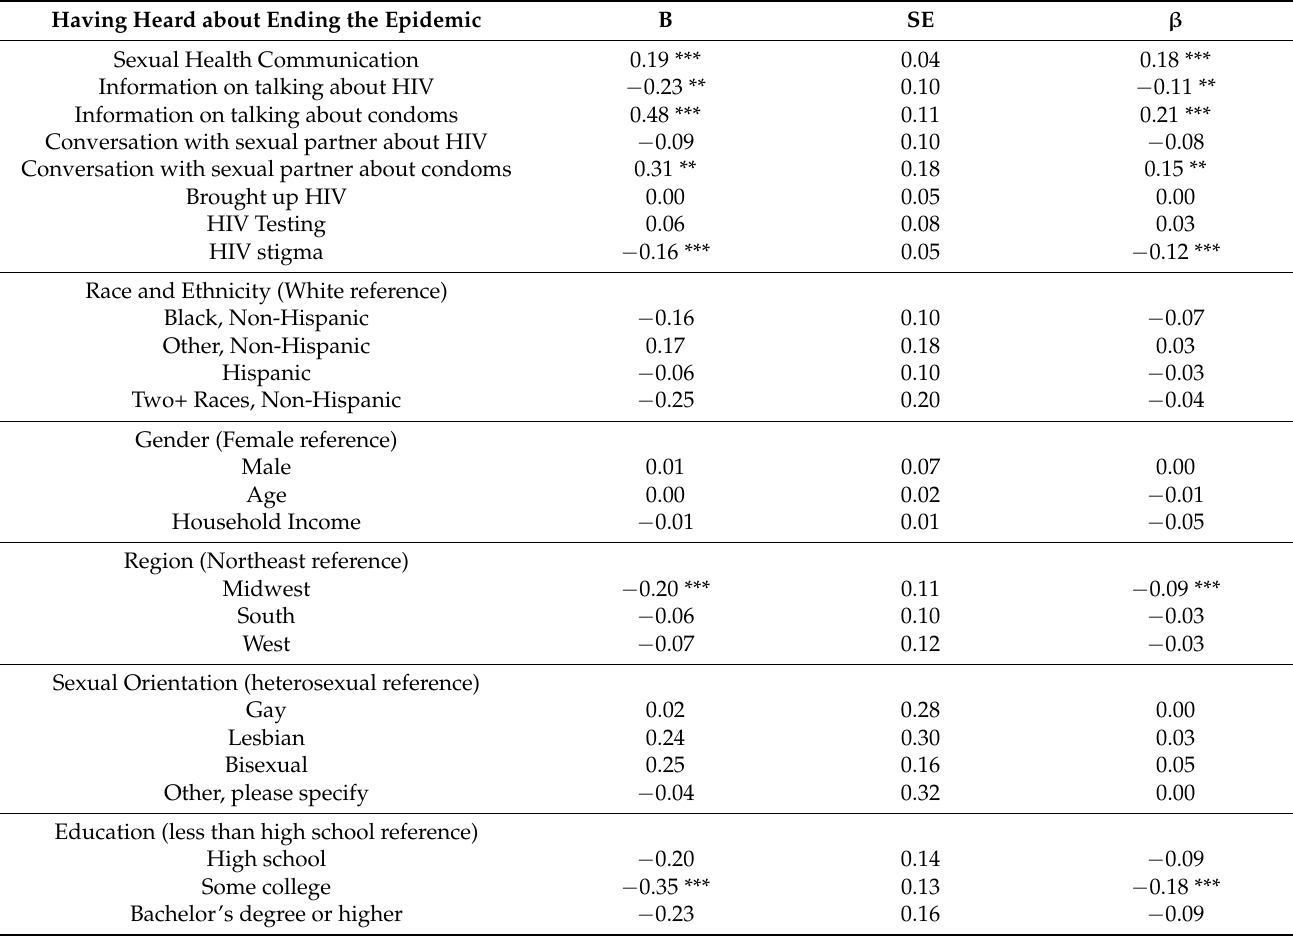
Table 3. Multivariate analysis among sexually active youth and young adults on having heard about ending the epidemic ( n = 701).